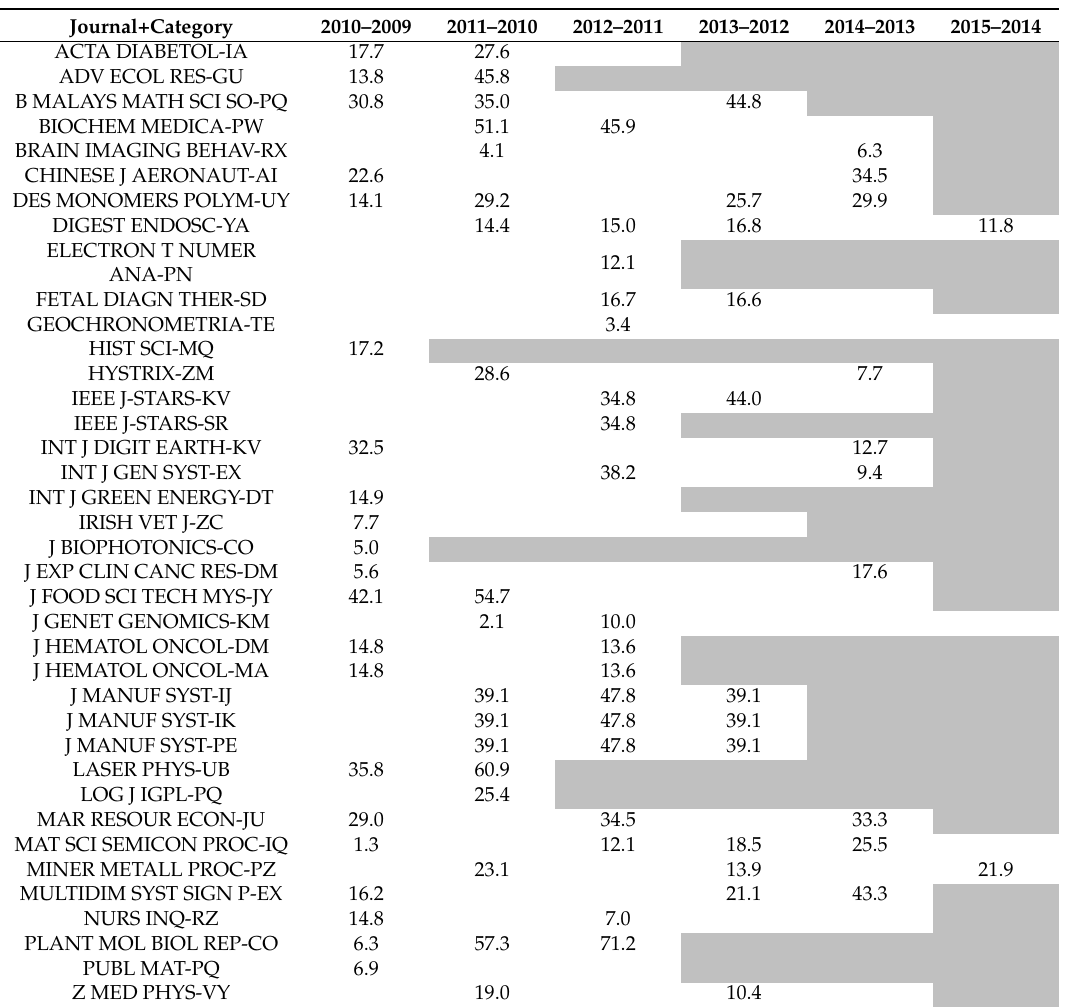
Table 4. Percentage of journal self-citations that contributed to the JIF in the final year in transitions that involved an increase in the number of total citations and journal self-citations that contributed to the JIF (JIF numerator), and with values of Q-Self-Citations greater than 1. Empty cells represent transitions that did not meet the above conditions. Grey cells represent years outside the study